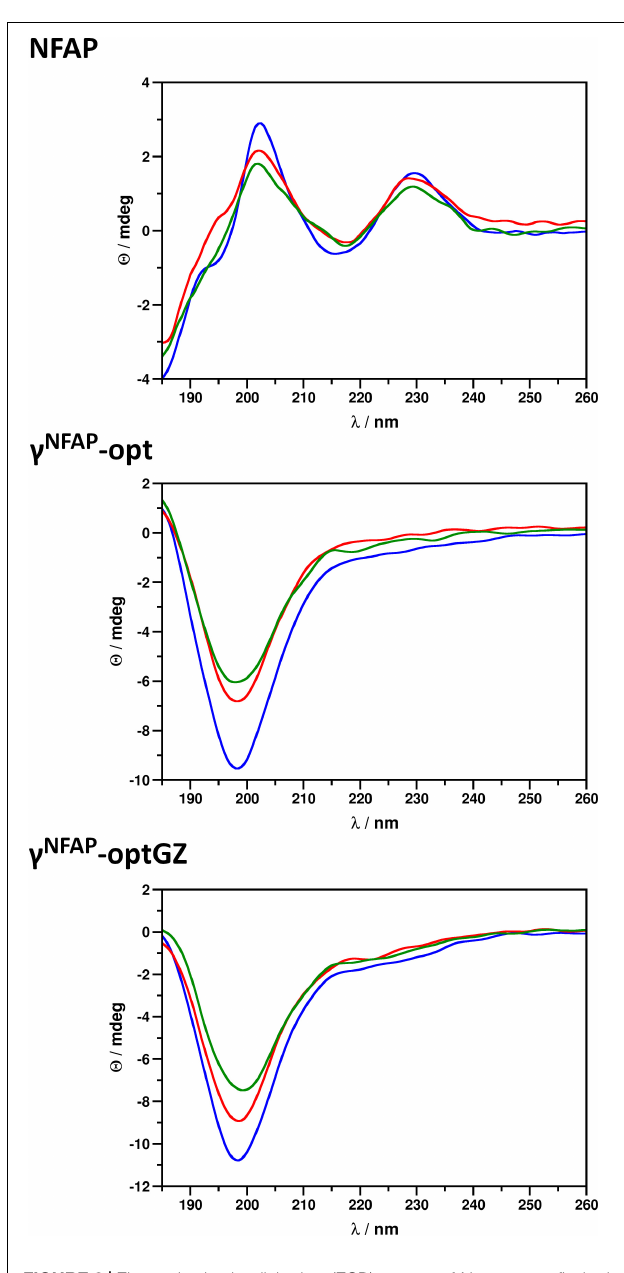
FIGURE 2 | Electronic circular dichroism (ECD) spectra of Neosartorya fischeri antifungal protein (NFAP), γ NFAP -opt, and γ NFAP -optGZ peptides in ddH 2 O (blue) and in the presence of Cladosporium herbarum FSU 1148 conidia immediately after exposure (red) to and after 24 h of co-incubation (green) with